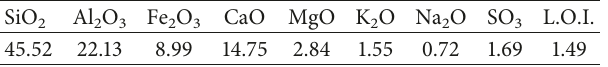
Table 1: Chemical composition of fly ash (%